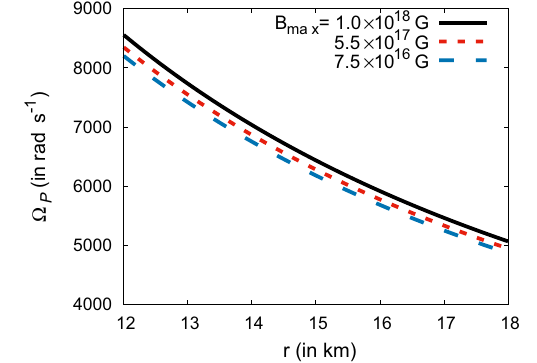
Fig. 20 We have plotted the effect of poloidal magnetic field on Ω P along the equatorial plane. Here we have Ω = Ω g . The black solid curve, the red short dashed curve and the blue dashed curve are for cen- tral magnetic field of 8 . 0 × 10 17 G , 5 . 0 × 10 17 G , 4 . 5 × 10 16 G respec- tively. The central energy density of the NS is taken to be 1 . 0 × 10 15 g cm − 3